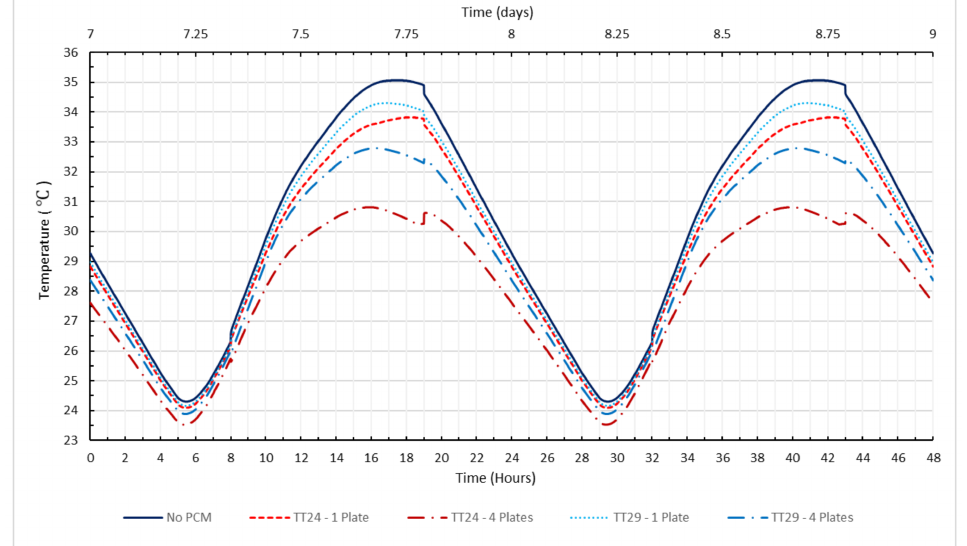
Figure 11. Indoor temperatures for the low inertia room and normal climate, with forced convection at the place